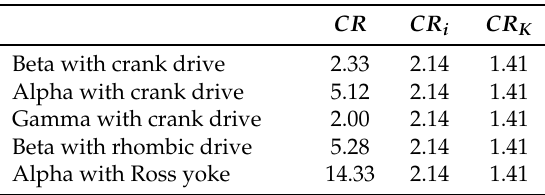
Table 3. Compression ratios for the analyzed